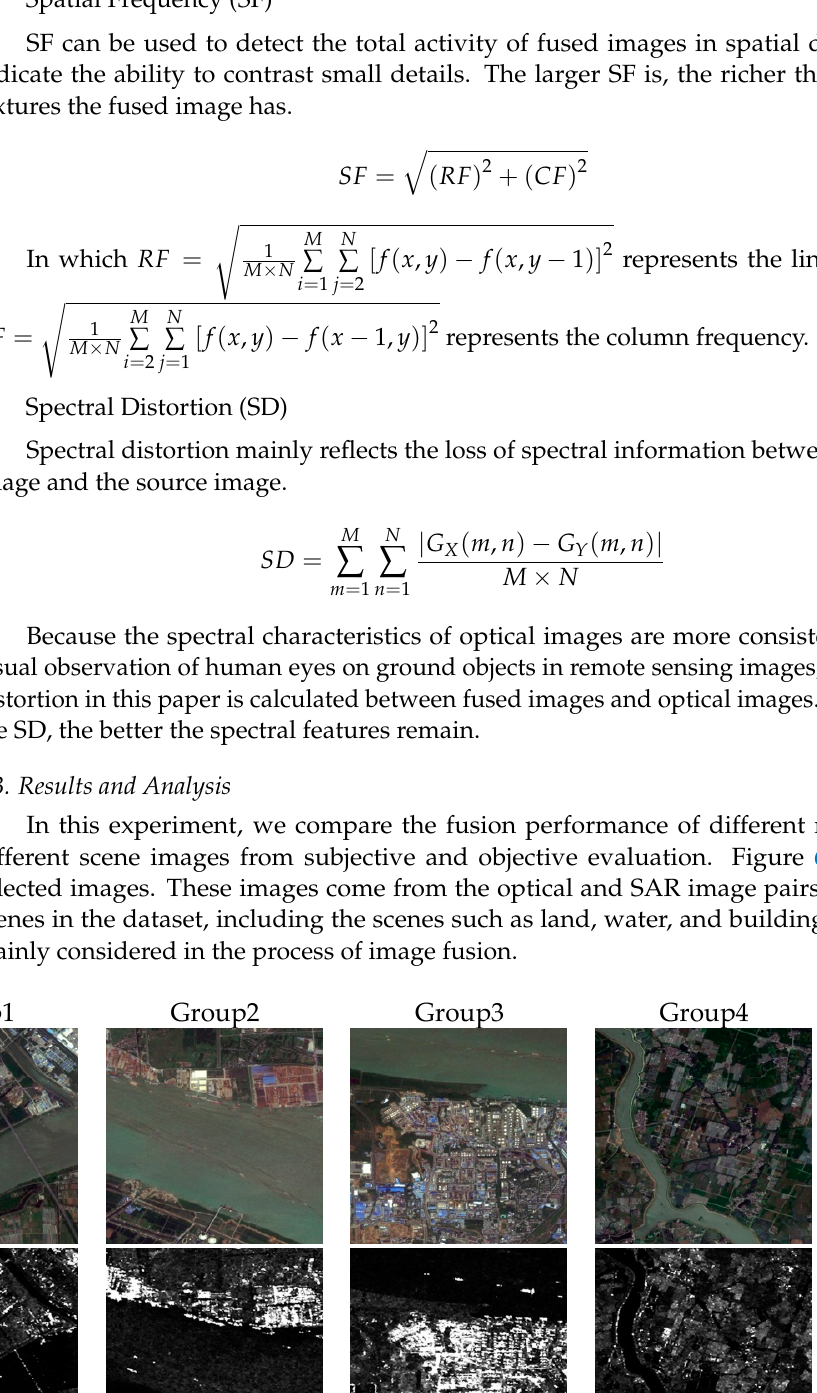
Table 1. Various network test results using the original loss function. EN